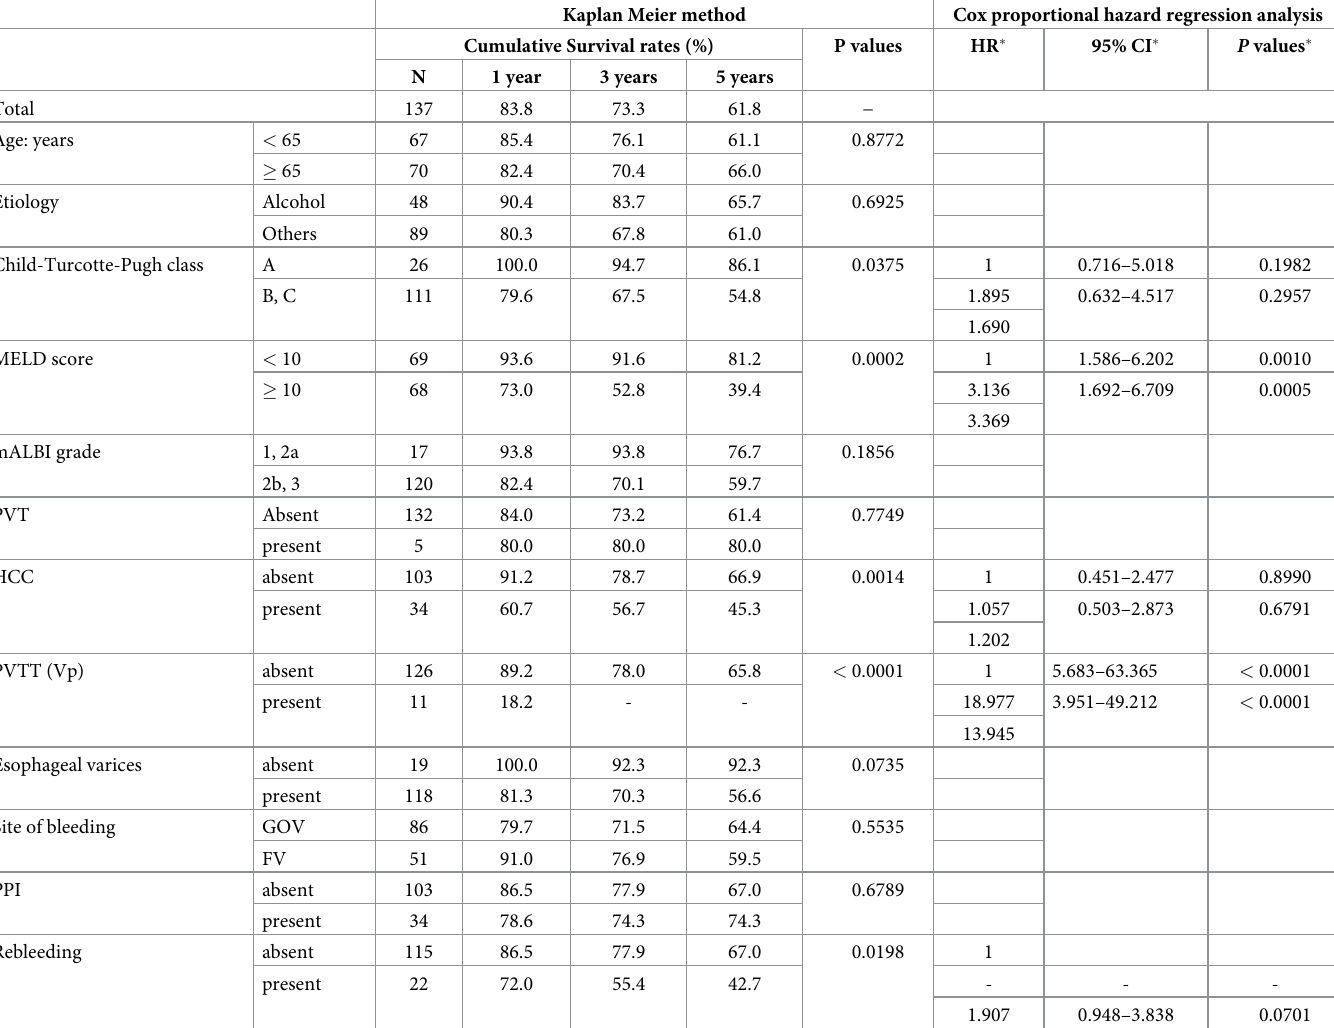
Table 3. Cumulative survival rates of the 137 enrolled patients with gastric variceal bleeding and factors associated with the outcomes of the patients.